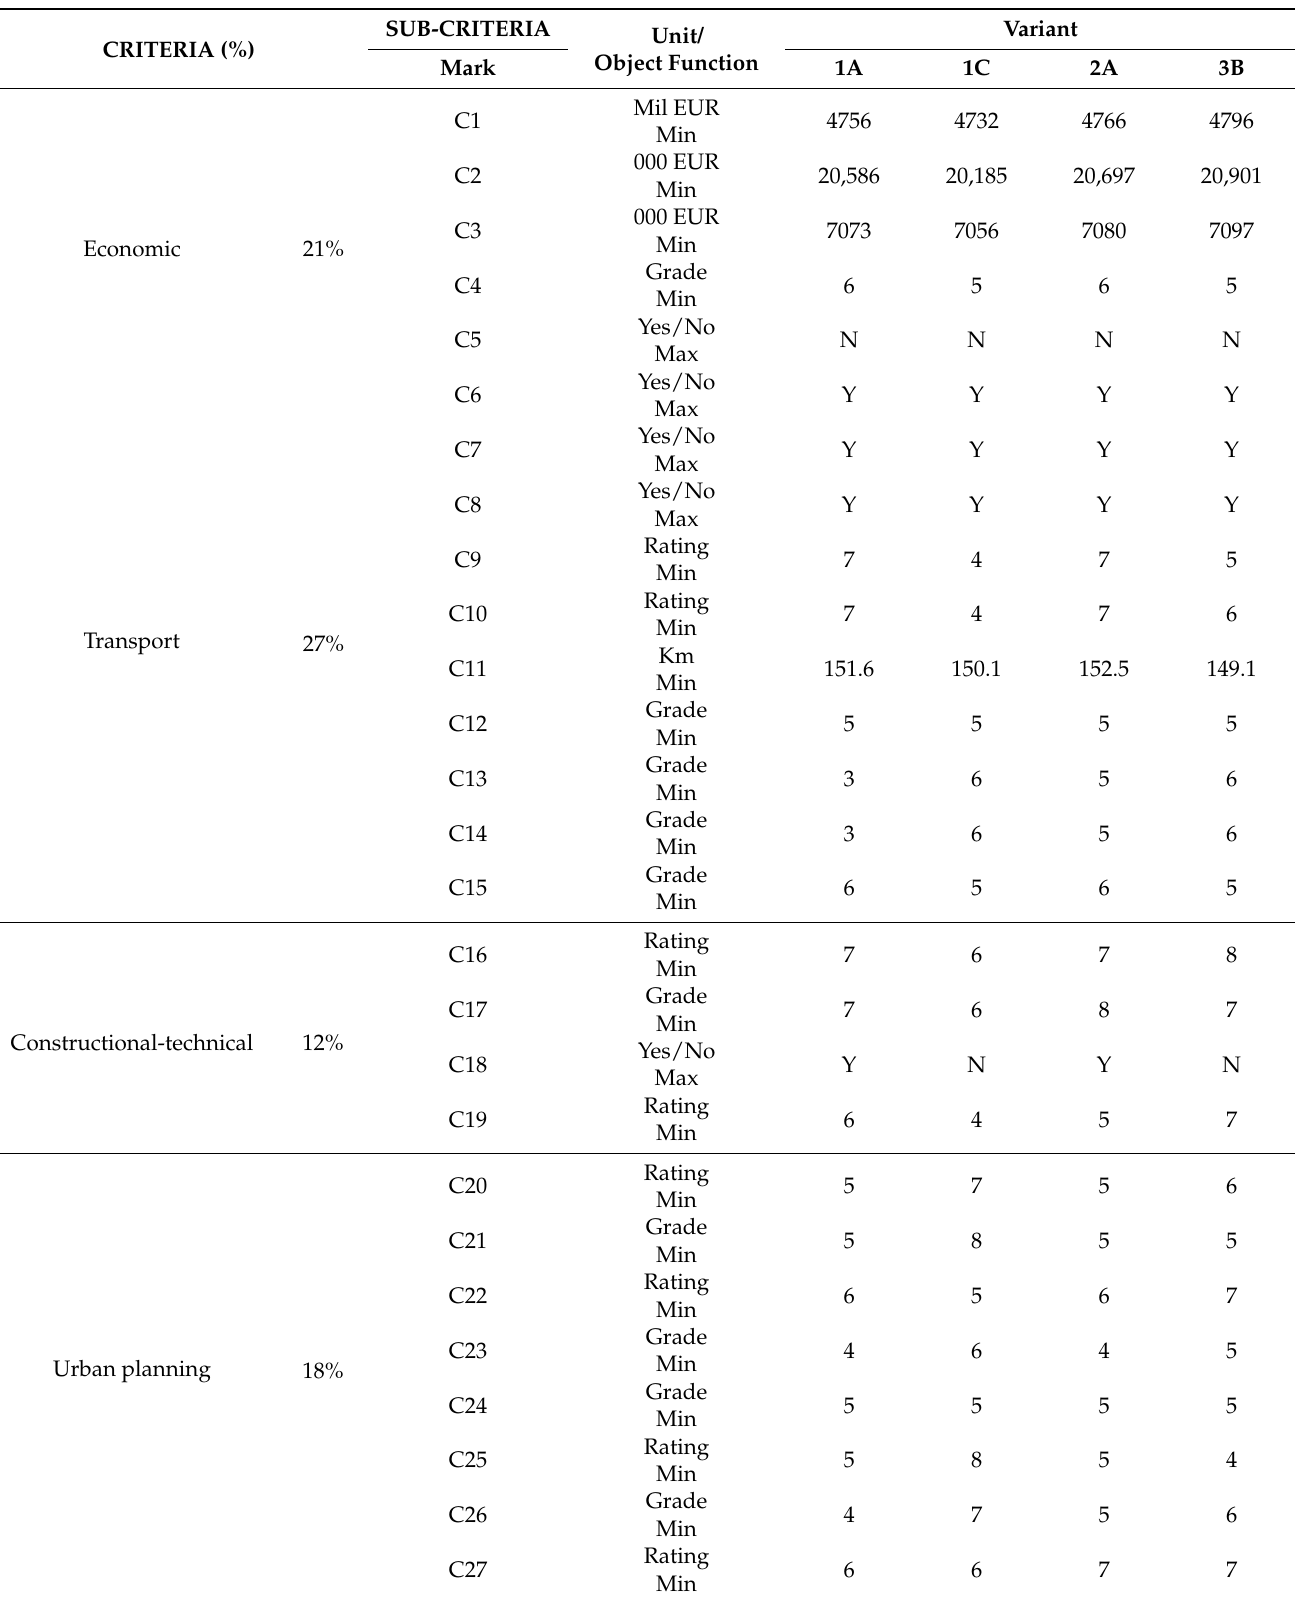
Table 2. Criteria evaluation for variant